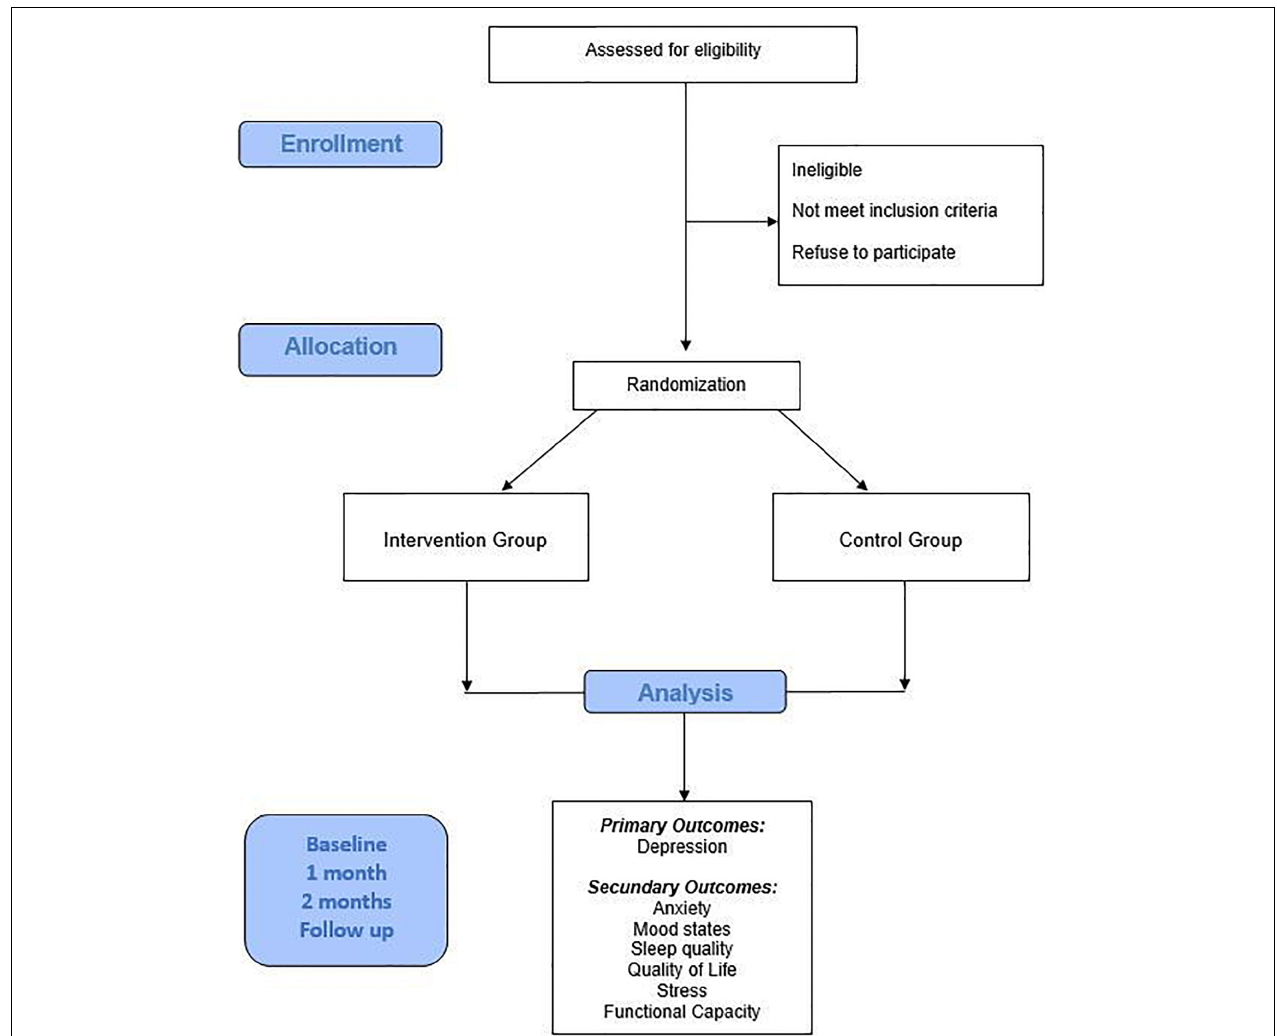
FIGURE 1 | Flowchart demonstrating the participant selection process and the steps of the study